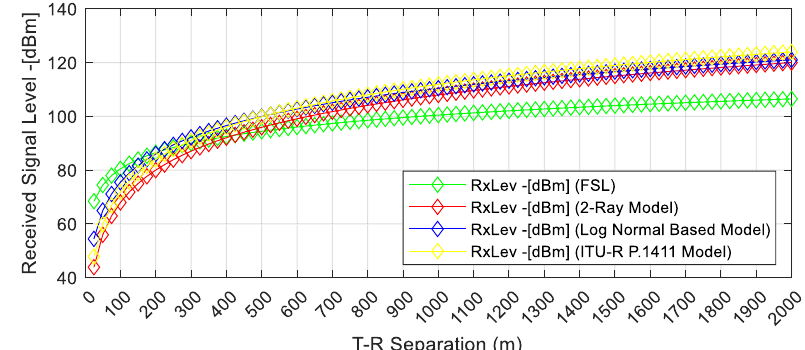
Fig. 10 Predicted Rx level as a function of distance (carrier frequency